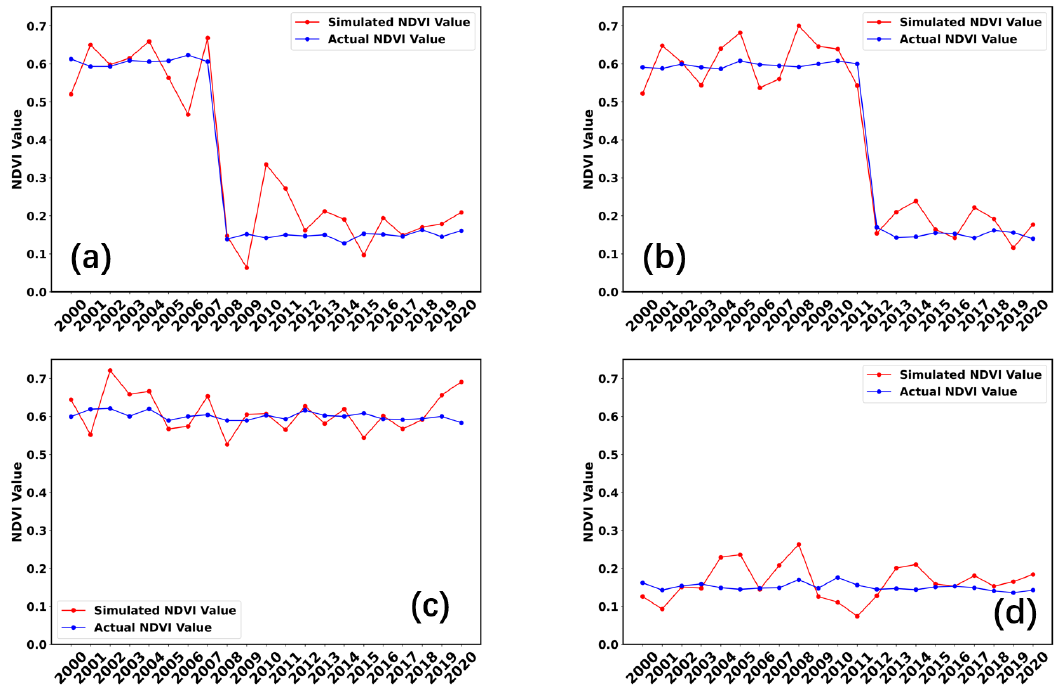
Figure 6. The Manhattan distance is used to calculate the distance between the actual NDVI sequence in the figure and the simulated NDVI sequence. Four cases are placed in the figure: ( a ) indicates that the disturbance occurred in 2007; ( b ) suggests that the disturbance occurred in 2011; ( c , d ) suggest that no land disturbance has occurred, ( c ) suggests stable vegetation; and ( d ) suggests a stable shale oil/gas